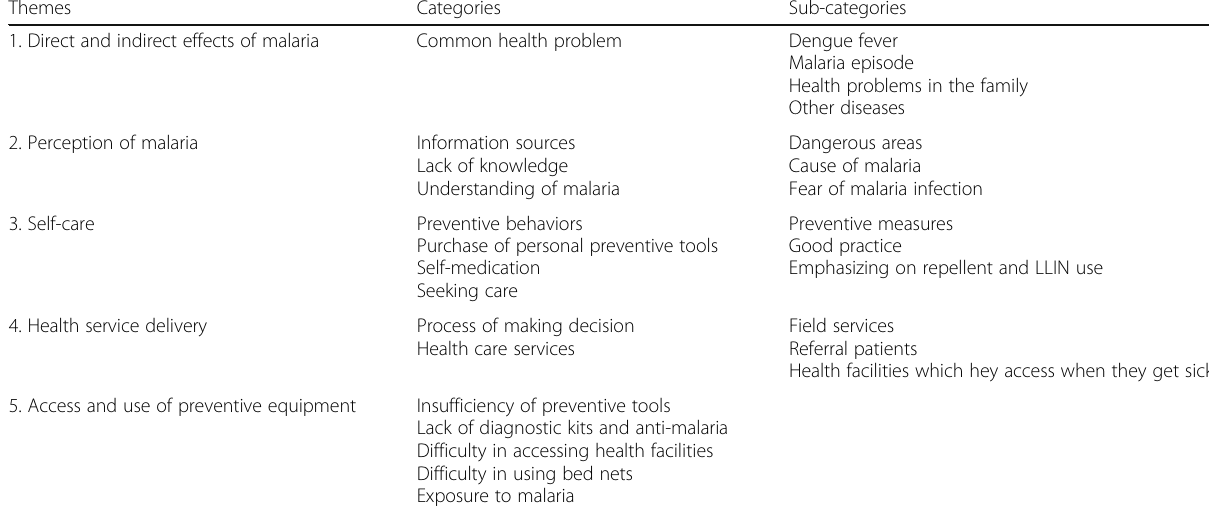
Table 6 Themes, categories, and sub-categories